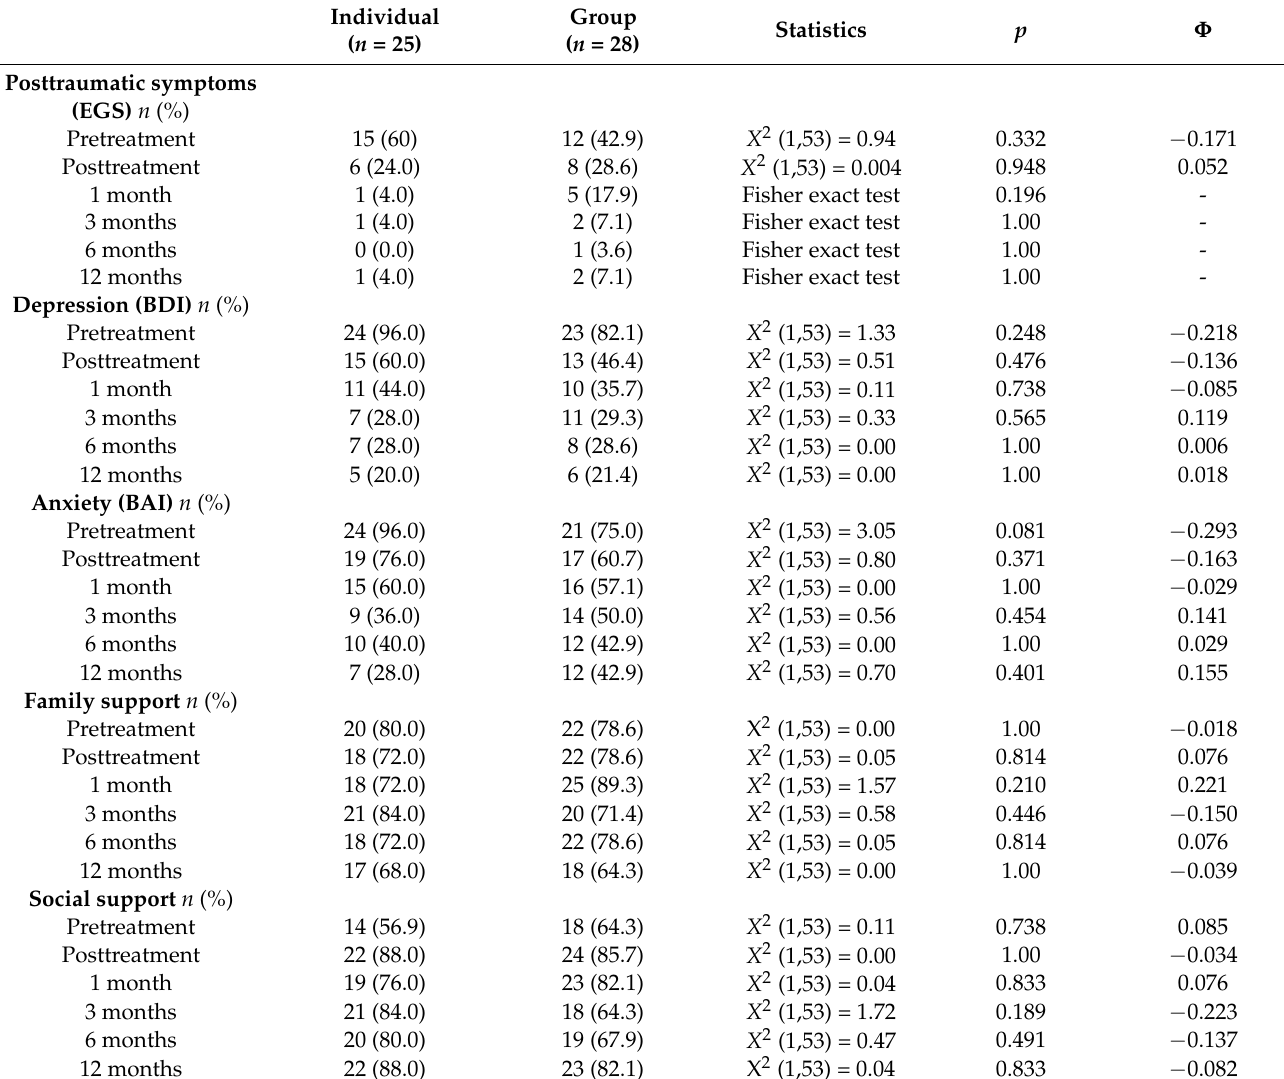
Table 3. Frequencies and comparisons between conditions in clinically significant symptomology and support ( n = 53). Individual ( n = 25)